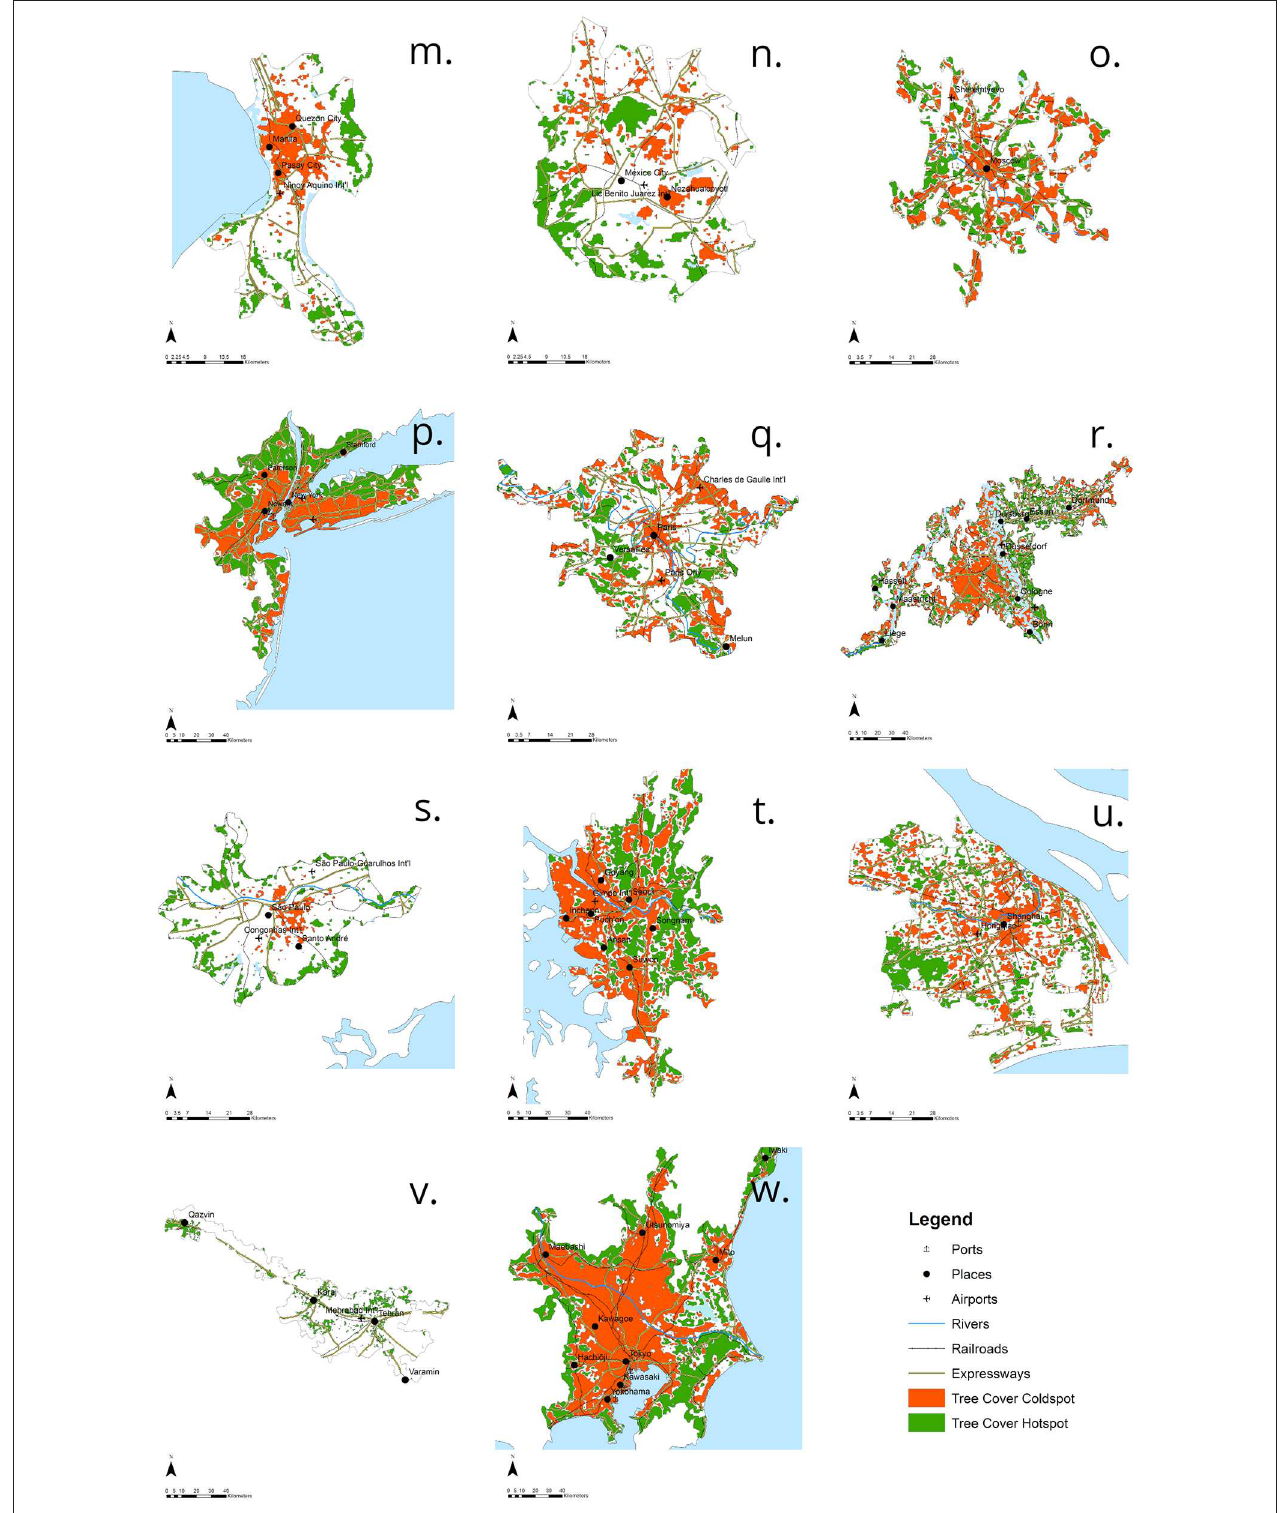
FIGURE 3B | The hot spot (green) and cold spot (red) clusters, city centers (dots), waters (blue), expressways (yellow lines), railways (black hashed lines), marine ports (anchors), airports (airplanes) within the metropolitan areas of: (a) Manila, (b) Mexico City, (c) Moscow, (d) New York City, (e) Paris, (f) Rhine Ruhr, (g) Sáo Paulo, (h) Seoul, (i) Shanghai, (j) Tehran, (k) Tokyo, (m) Manila, (n) Mexico City, (o) Moscow, (p) New York City, (q) Paris, (r) Rhine Ruhr, (s) Sáo Paulo, (t) Seoul, (u) Shanghai, (v) Tehran, (w) Tokyo.